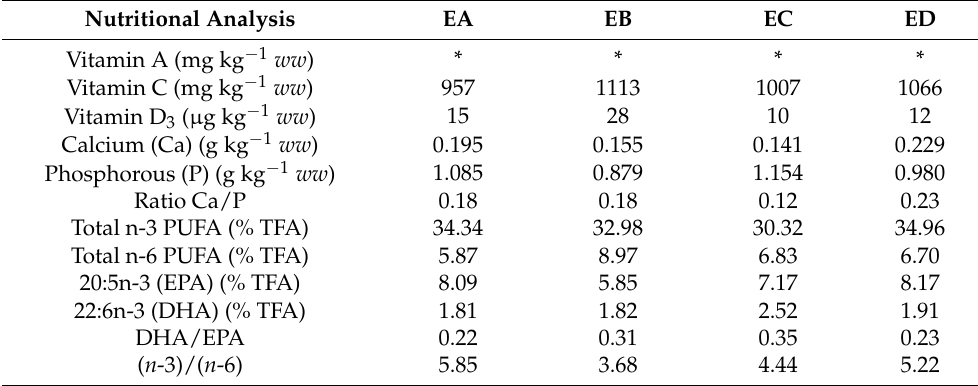
Table 4. Nutritional composition of Artemia spp. metanauplii enriched with four different products (EA, EB, EC, ED). DHA: docosahexaenoic acid; EPA: eicosapentaenoic acid; PUFA: polyunsaturated